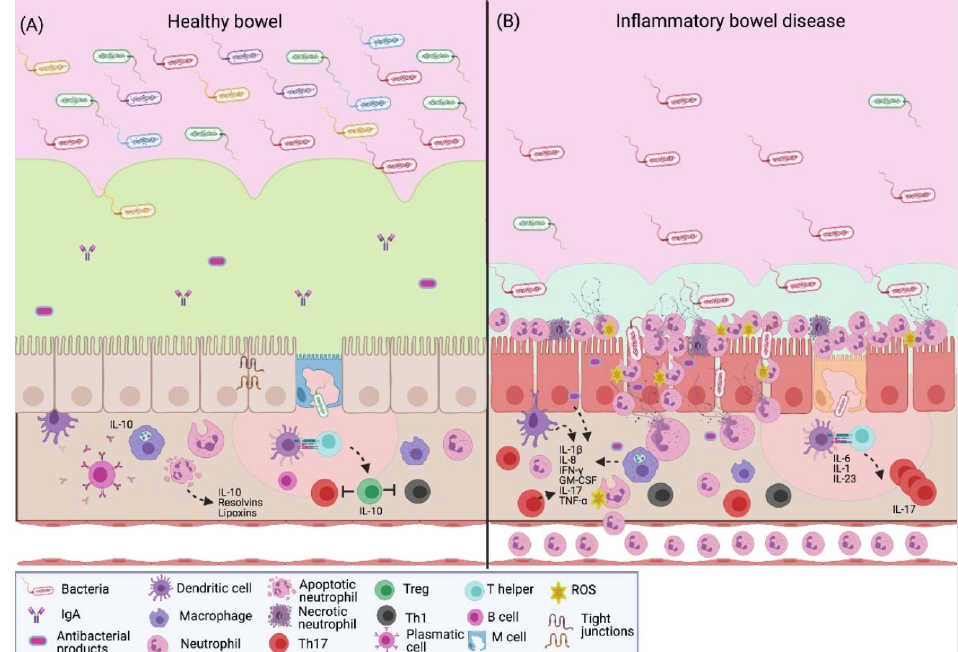
Figure 2. NETs in inflammatory bowel disease. ( A ) The intestinal barrier protects the host against pathogens; it promotes homeostasis between the commensal microbiota and the immune system. In healthy intestinal mucosa, the epithelium is covered with mucus that contains antimicrobial peptides and IgA. In the lamina propria, immune cells are strategically distributed to initiate a response. There is a constant antigen presentation to establish immune tolerance towards the gut microbiota. Mucosal neutrophils prevent the antigen translocation; their apoptosis promotes mucosal injury repair through the secretion of resolvins and lipoxins; it also leads to the M2-type macrophages, which secrete IL-10 to create a microenvironment where Treg lymphocytes predominate. ( B ) Patients with IBD present dysbiosis and a low expression of tight junction proteins, which leads to an increase in intestinal permeability. Epithelial and immune cells produce proinflammatory cytokines (IL-1 β , IL-8, IFN- γ , GM-CSF, TNF- α and IL-17) that increase the transendothelial migration and neutrophil activation to create a microenvironment where the activity of Th17 lymphocytes predominates. Neutrophils respond to luminal antigens through a respiratory burst, degranulation and the release of extracellular traps with antimicrobial factors, such as elastase and myeloperoxidase, which contribute to the characteristic colonic tissue damage in these patients. IgA, immunoglobulin A; IL-1 β , interleukin-1 β ; IL-6, interleukin-6; IL-8, interleukin-8; IL-10, interleukin-10; IL-17, interleukin-17; IL-23, interleukin- 23; IFN- γ , interferon gamma; GM-CSF, granulocyte-macrophage colony-stimulating factor; TNF- α , tumor necrosis factor- α ; ROS, reactive oxygen species. Created with